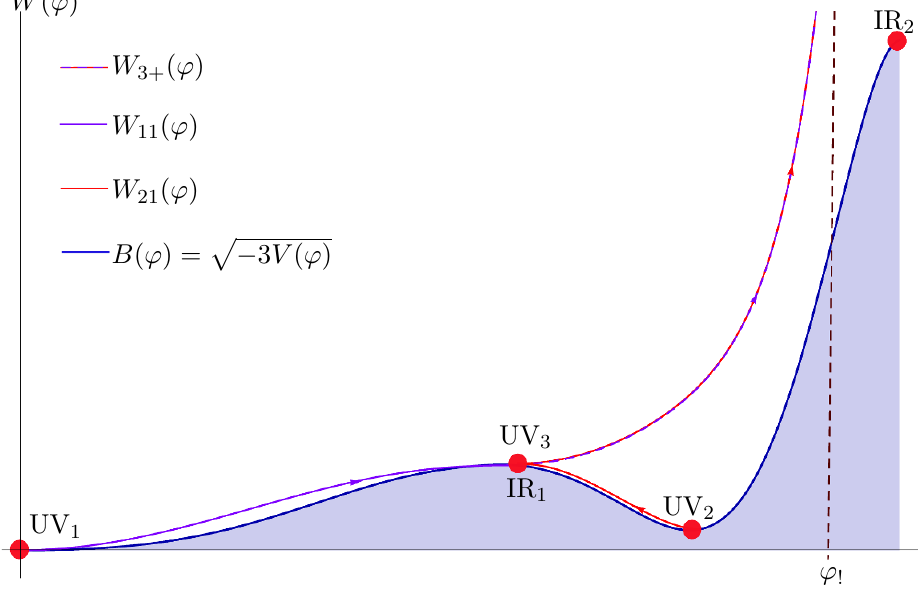
Figure 31. RG (cid:13)ows with IR endpoint ’ 0 ! ’ ! . When the endpoint ’ 0 approaches ’ ! (cid:13)ows from both UV 1 and UV 2 pass by closely to IR 1 , passing through IR 1 exactly for ’ 0 = ’ ! . This is shown by the purple and red curves. Beyond IR 1 both these solutions coincide, which is denoted by the colored dashed curve. These have the following interpretation. The (cid:13)ows from UV 1 and UV 2 should not be continued beyond IR 1 , which becomes the IR endpoint for the zero curvature (cid:13)ows W 11 and W 21 . The remaining branch (the colored dashed curve) is now an independent (cid:13)ow denoted by W 3+ . This is a (cid:13)ow from a UV (cid:12)xed point at a minimum of the potential (denoted by UV 3 above) to ’ ! and corresponds to a W + solution in the notation of section 3 with (cid:12)xed value R = R uv j ’ + j (cid:0) 2 = (cid:1) + 6 = 0. While (cid:13)ows from UV 1 and UV 2 can end arbitrarily close to ’ ! , the endpoint ’ 0 = ’ ! cannot be reached from UV 1 or UV 2